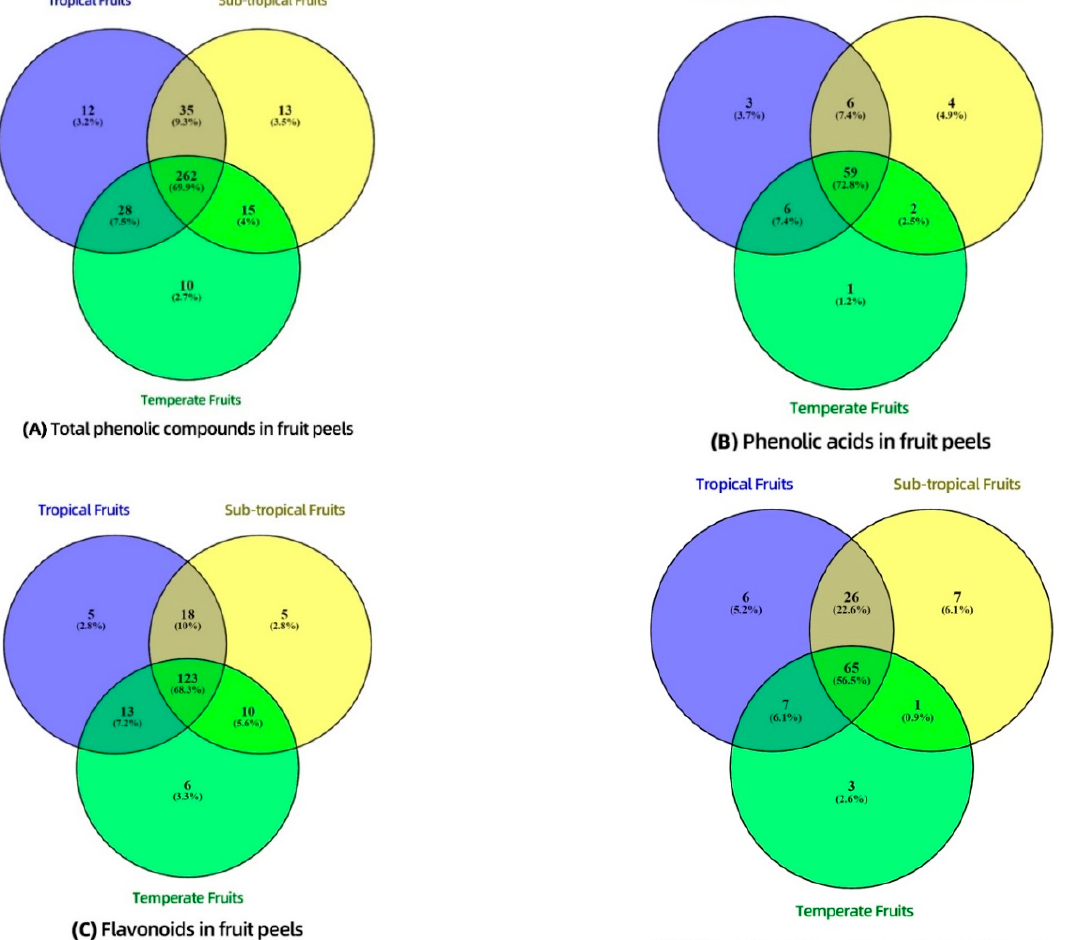
Figure 3. Venn diagram of phenolic compounds presented in different fruit peel samples grown in different regions. ( A ) shows the relations of total phenolic compounds present in different fruit peel samples grown in three different zones. ( B ) shows the relations of phenolic acids present in different fruit peel samples. ( C ) shows the relations of flavonoids present in different fruit peel samples. ( D ) shows the relations of other phenolic compounds present in different fruit peel samples.